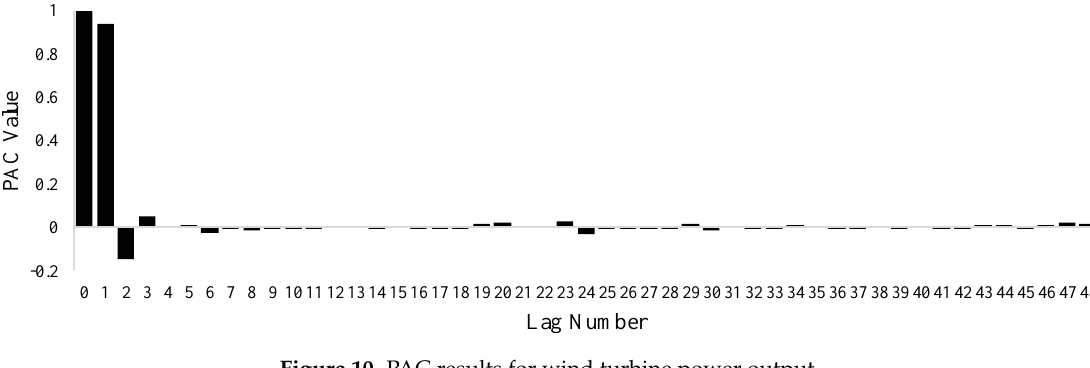
Figure 10. PAC results for wind turbine power